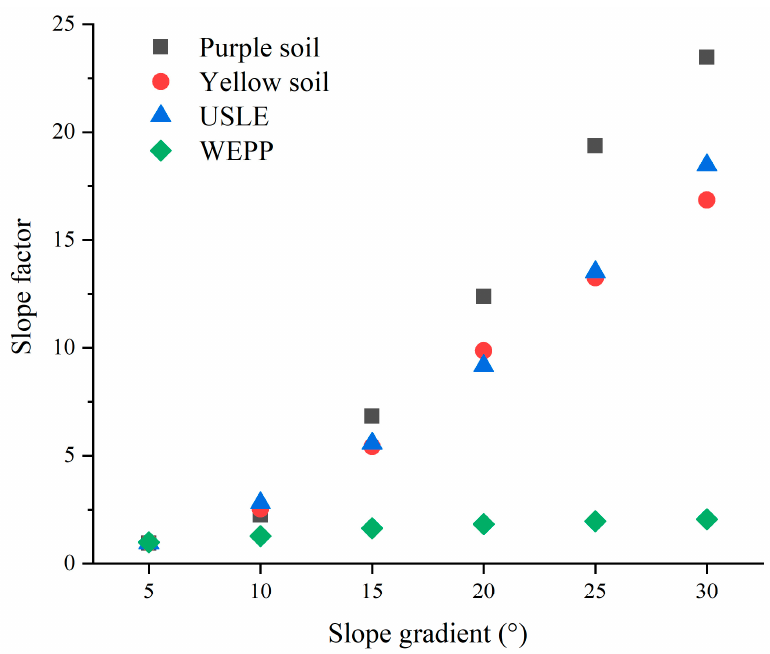
Figure 6. Comparison of calculated and measured values of slope factors for two kinds of soils.